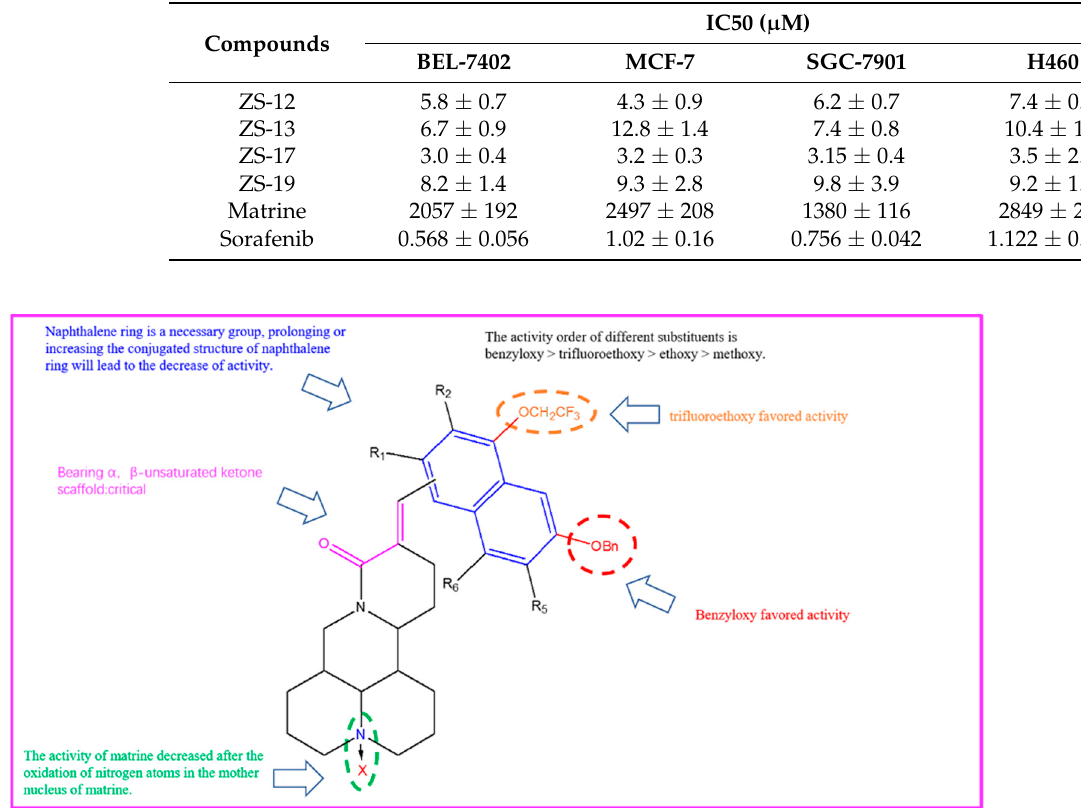
Figure 1. Structure–activity relationship for matrine derivatives. Table 1. The IC50 ( μ M) value of compounds against human tumor cell lines for 48 h. The inhibitory effects of ZS17 on liver cancer cell lines were evaluated at increasing concentrations for 24, 48, or 72 h. The inhibitory activity (IC 50 ) of ZS17 against the growth of BEL-7402 and HepG2 cells was approximately 3.014 and 3.388 µ M, respectively, after 48 h (Figure 2A–C). ZS17 had a significant inhibitory effect on the proliferation of liver cancer cells compared with matrine exposure (Figure 2E–G). This suggested that ZS17 selectively inhibits BEL-7402 and HepG2 cells. Lactate dehydrogenase is mainly located in the cytoplasm and can be used to reflect the destruction of cell membrane integrity in extracellular culture medium. The results showed that the release of LDH from BEL-7402 and HepG2 cells treated with different concentrations of ZS17 for 48 h was dose-dependent (Figure 2D,H). Moreover, the nuclei were of different sizes, indicating that apoptosis of BEL-7402 and HepG2 cells was promoted by ZS17